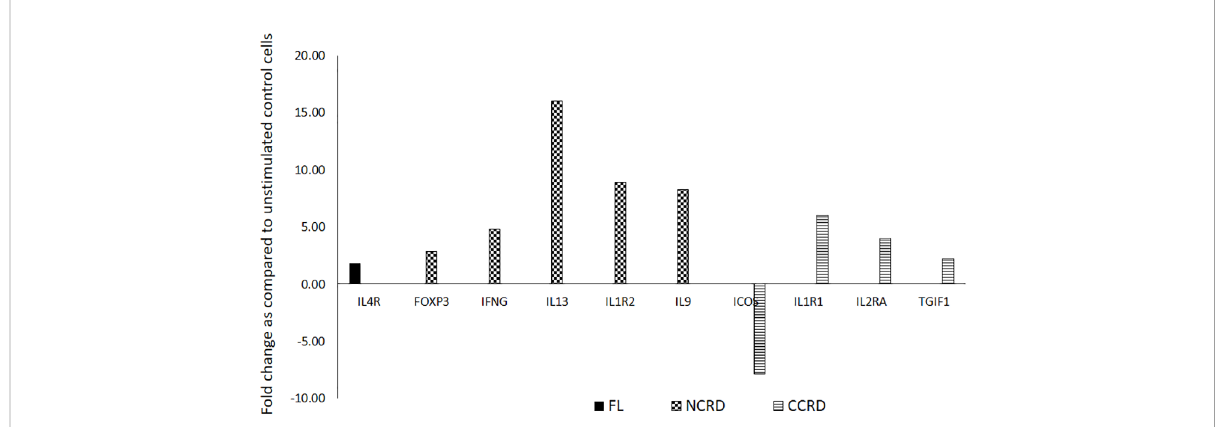
FIGURE 7 T helper cell activation pro fi le induced by the full-length and individual CRDs of galectin-9 using T helper activation RT pro fi ler PCR array and ABI 7500HT system. Genes showing signi fi cant up- or downregulation after treatment with the full-length, N-CRD, and C-CRD Gal-9 proteins are